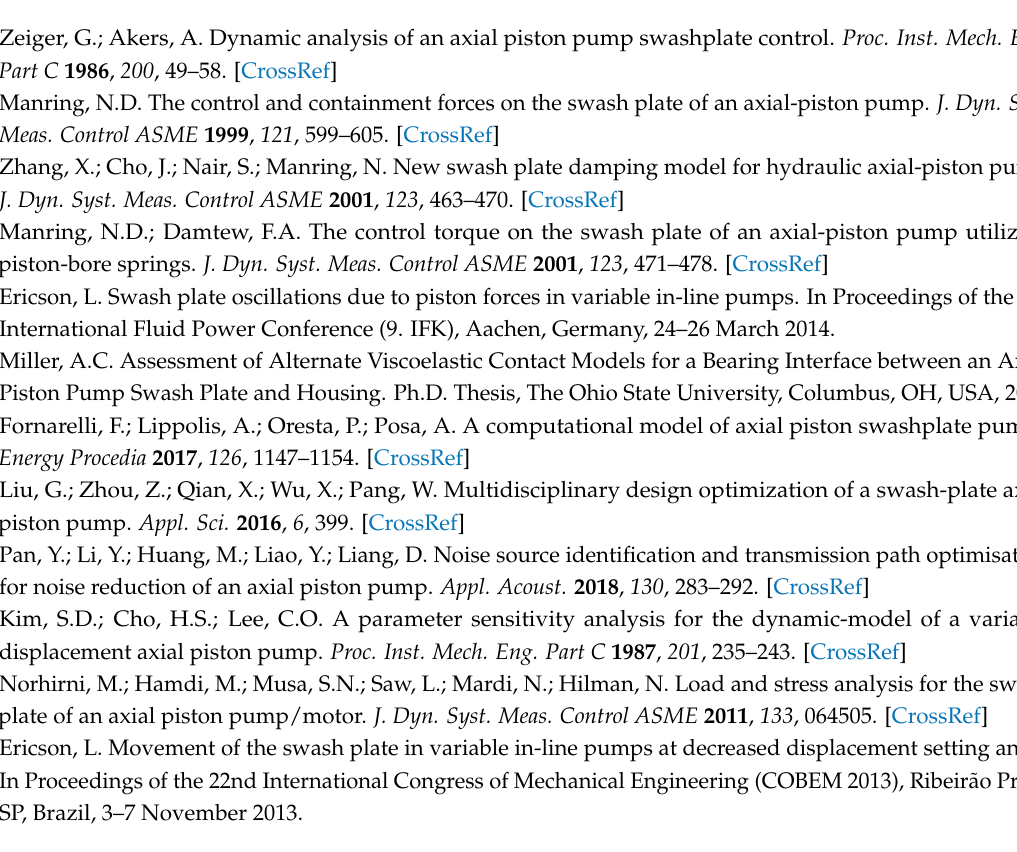
Figure S1: The photo of the drive module of the test rig, Figure S2: The photo of the oil source module of the test rig, Figure S3: The photo of the angle measurement